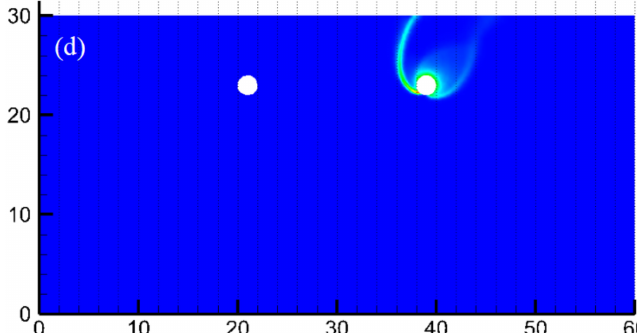
Figure 9. Upper bound failure mechanisms with H / D = 3, γ D / c = 1, k h = 0.1 and ϕ = 10 ◦ for